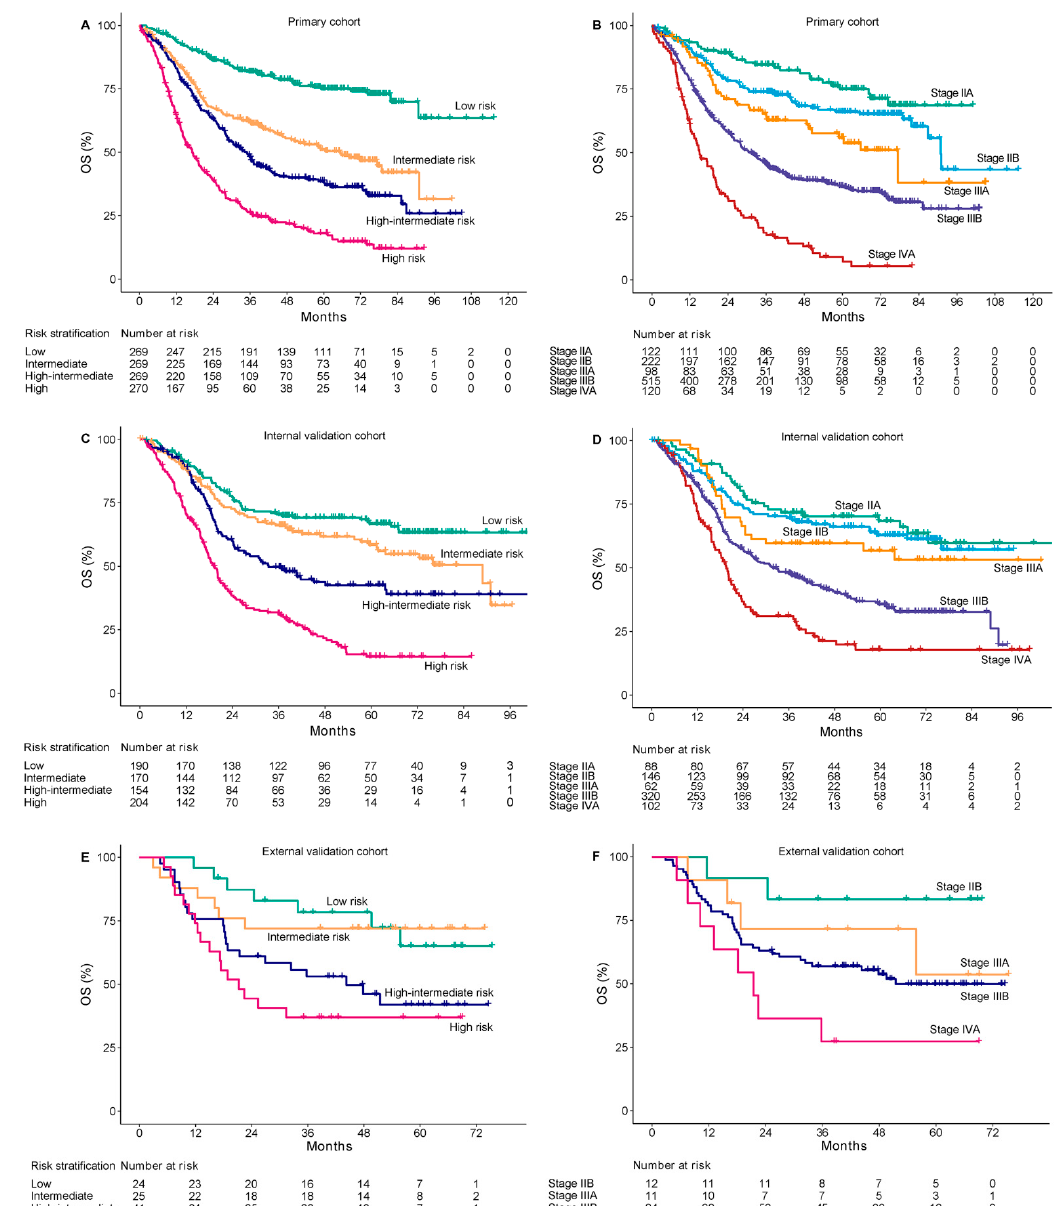
Figure 4. Kaplan–Meier overall survival curves of according to the quartile stratification of nomogram score and 8th AJCC TNM stage. The primary cohort ( A , B ), internal validation cohort ( C , D ), and external validation cohort ( E , F ). OS, overall survival.